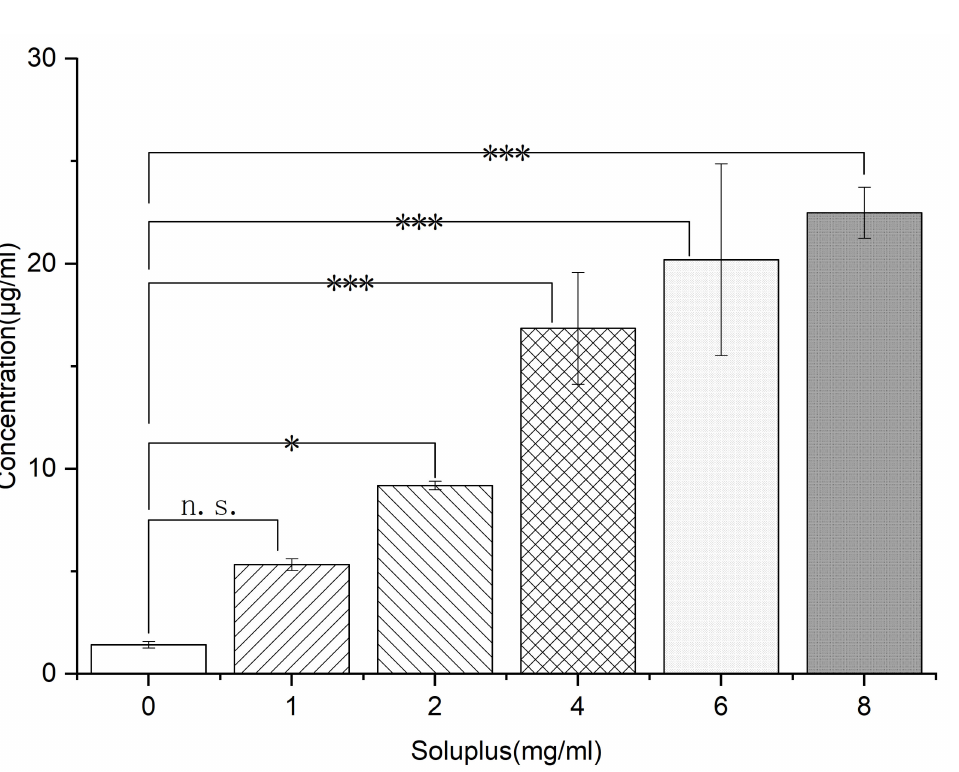
Figure 13. Phase solubility diagram of NIT in PBS (pH 6.8) mixed with pre-dissolved Soluplus ® polymers at different concentrations (from 0.1 to 0.8 mg/mL) at 37 ◦ C. * p < 0.05, *** p < 0.001 n. s., no significant difference. Standard deviations are expressed as error bars ( n = 3).